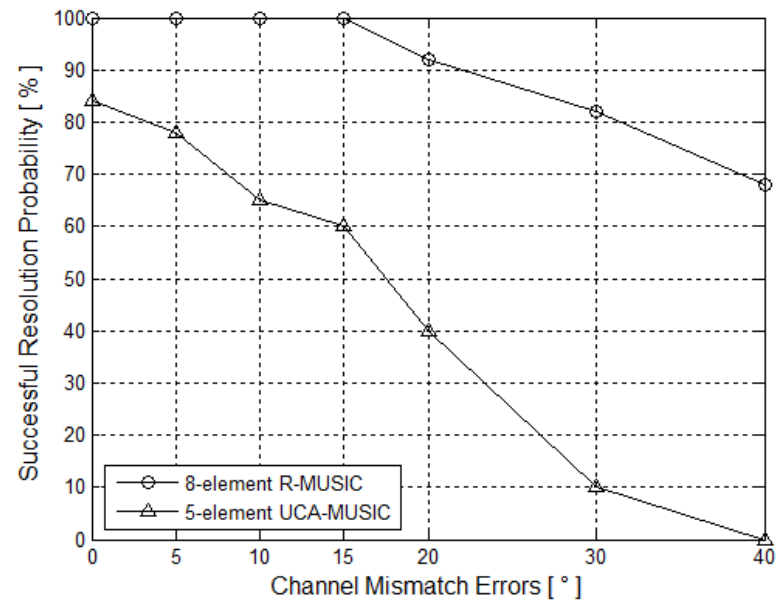
Figure 8. Successful resolution probability versus different channel mismatch errors.